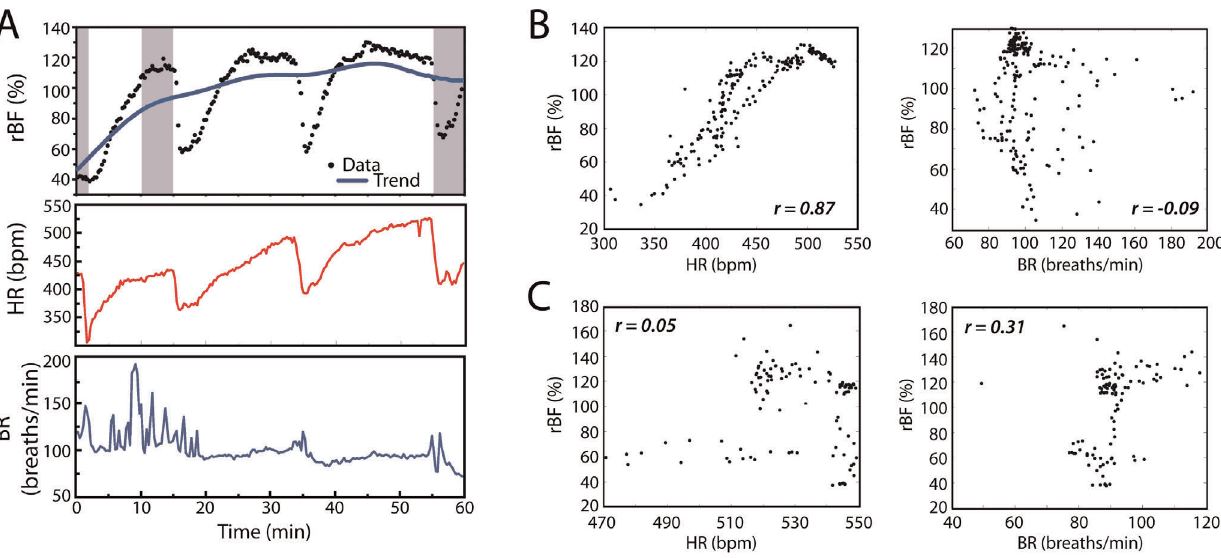
Figure 3. Tumor blood flow is closely associated with animal heart rate. (A) Representative time-courses of tumor rBF, heart rate (HR) and breath rate (BR) for a C3H animal during one hour of unperturbed monitoring. The shadowed areas represent the time periods for trend analysis presented in Table 1, while the blue line shows the fitted global trend line. (B) For the animal in ‘‘A’’, scatter plots (at time lag 0) depict the association between rBF and HR (left) or rBF and BR (right) during the one hour of baseline monitoring or (C) during PDT. The r values in the scatter plots represent the maximum cross-correlation value between the two variables.